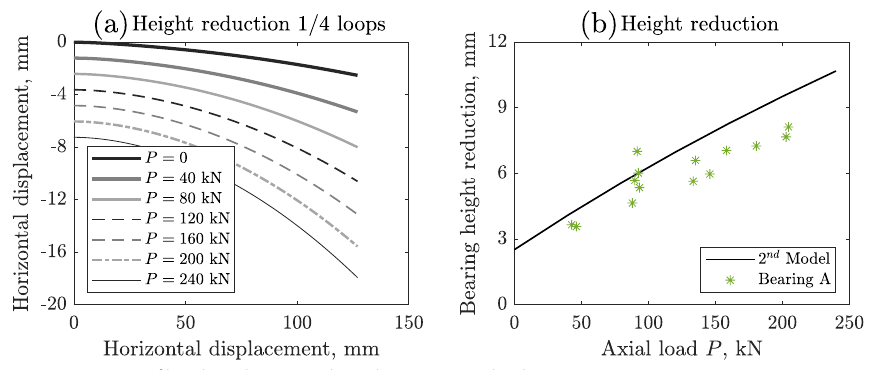
Fig. 10 Variation of height reduction with axial compression